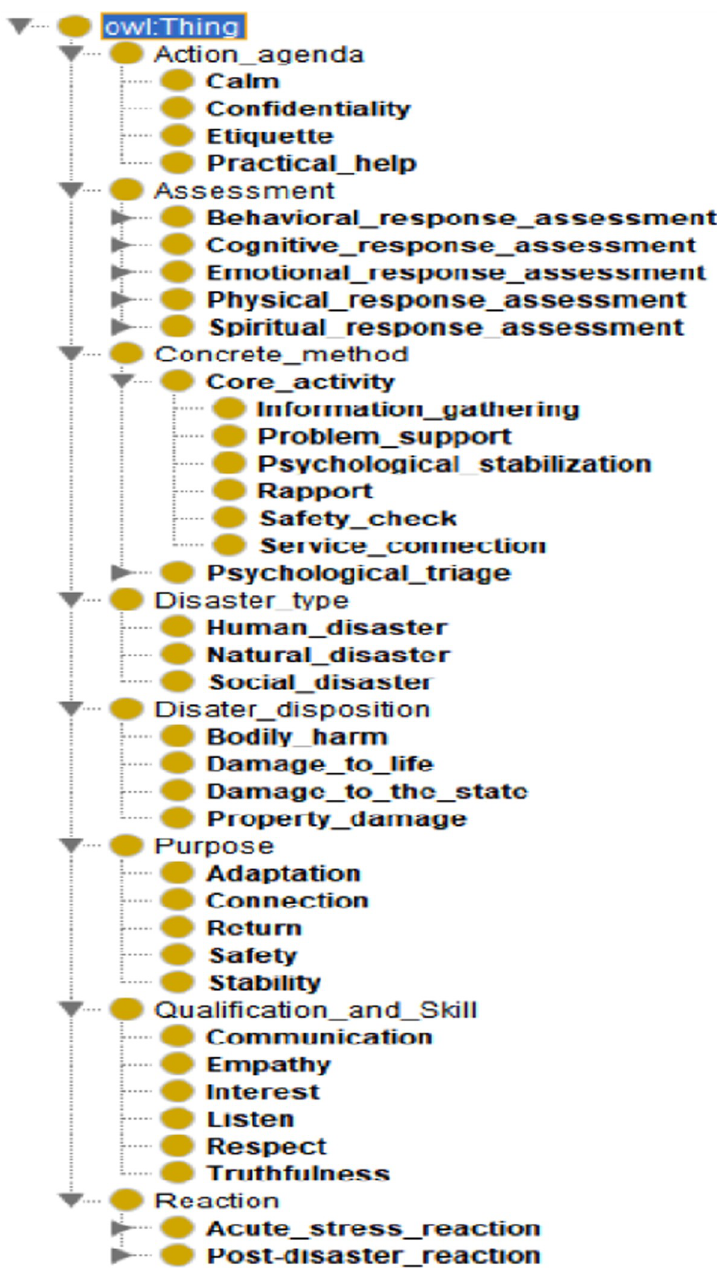
Fig 2. Class concept